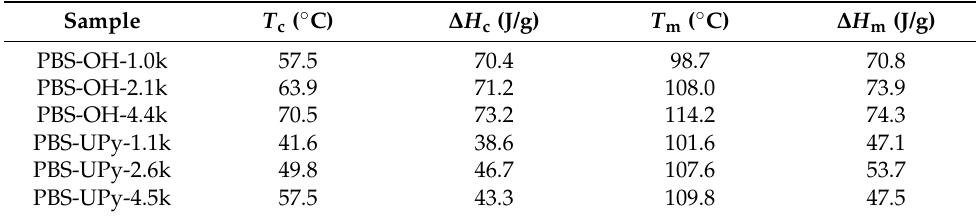
Table 2. Crystallization peak temperatures ( T c ), crystallization enthalpy ( ∆ H c ), melting temperatures ( T m ) and melting enthalpy ( ∆ H m ) of PBS-OH and PBS-UPy samples during the melt-cooling and reheating process with a rate of 10 °C/min. The enthalpy values of PBS-UPy samples were obtained by dividing the as-measured enthalpies by the mass fraction of PBS in PBS-UPy.